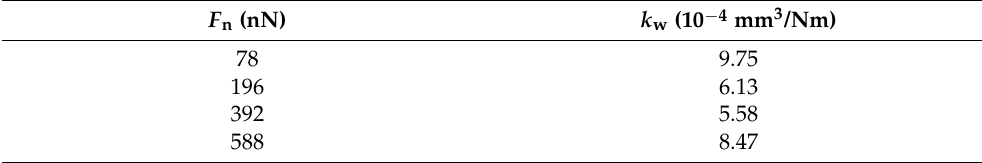
Table 1. The wear rate k w in the stable sliding stage under different load